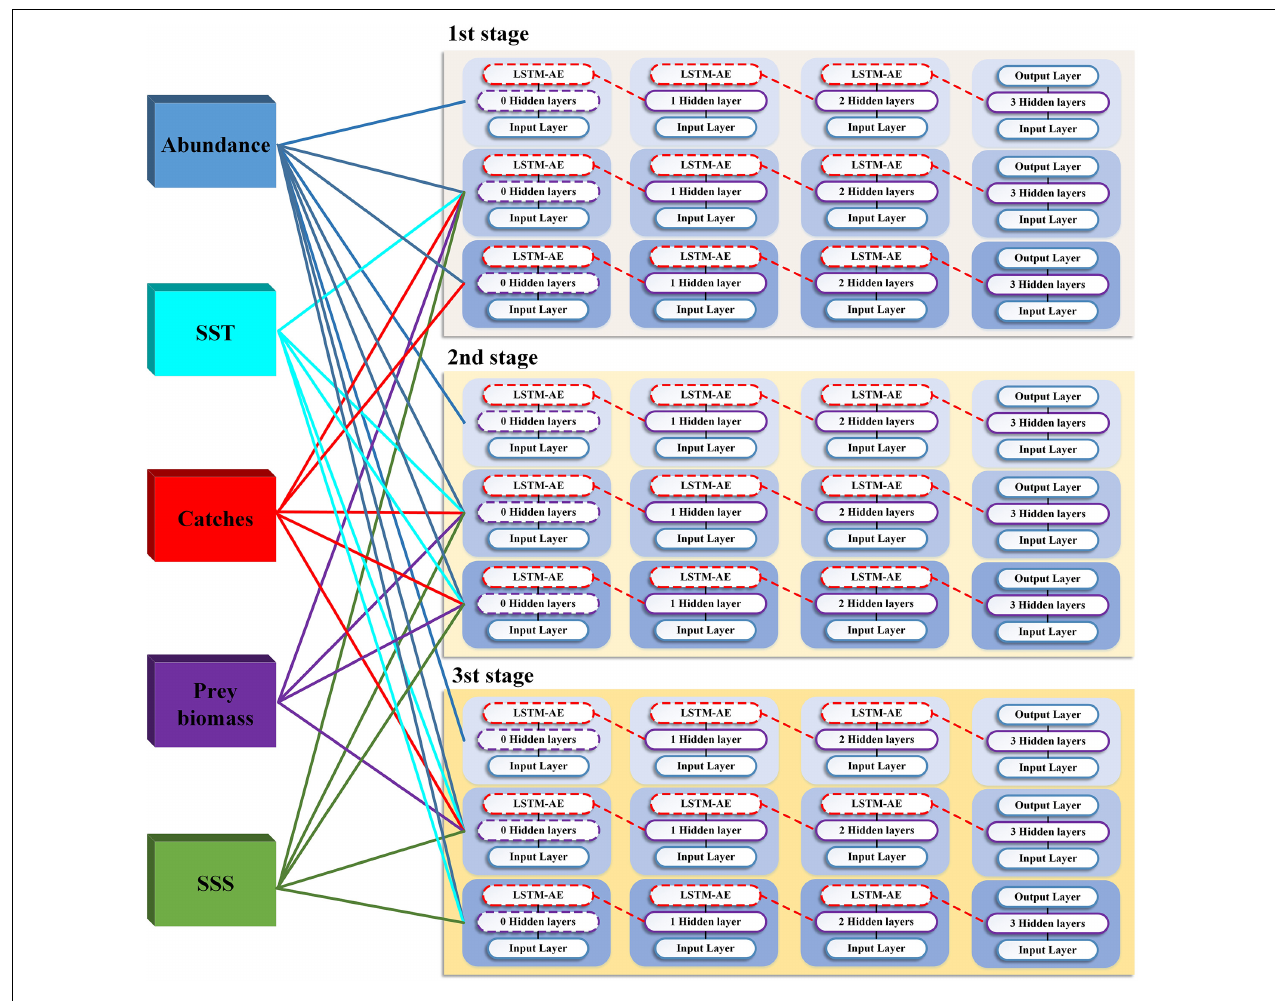
FIGURE 8 | LSTM-SAE predictive